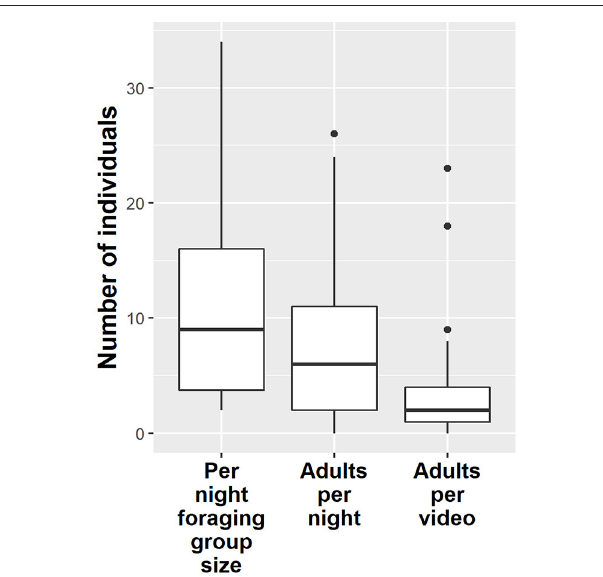
FIGURE 1 | The cubs’ per night foraging groups (including adults and other cubs) comprise 10.7 individuals on average (left box). As many foraging groups contained several cubs, the average per night number of adults observed around a cub is lower, at 7.1 individuals (middle box). Per video, the average number of adults is even lower, 2.5, indicating that cubs are not always accompanied by the same group of adults.